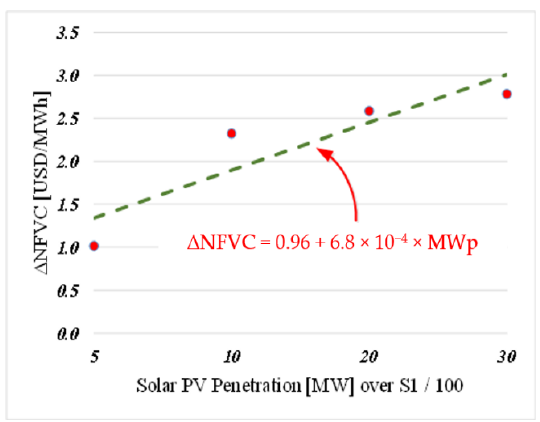
Figure 3. Variation of ∆NFVC with solar photovoltaics (PV) penetration.